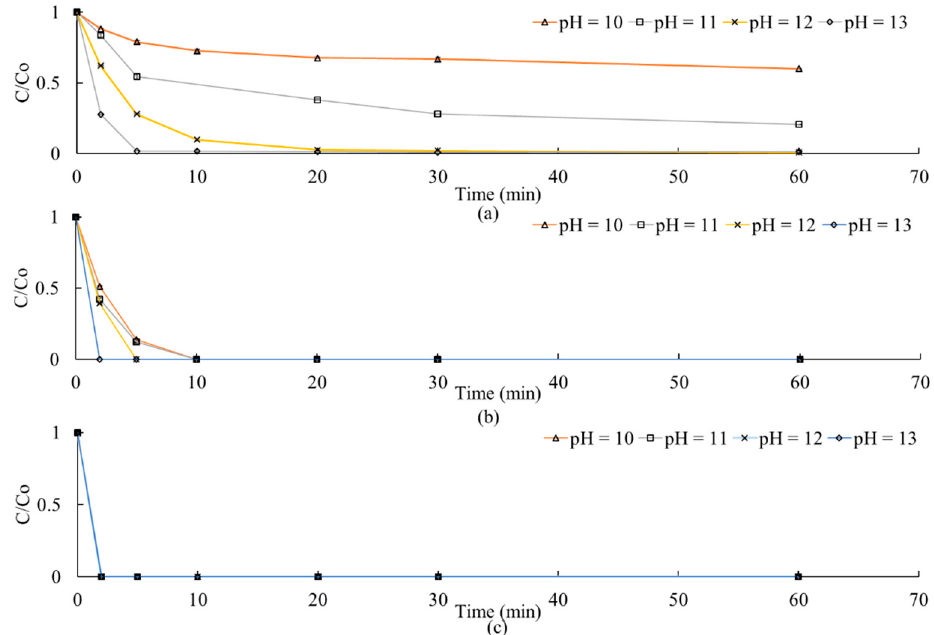
Figure 6. Sulfolane degradation in SWW with alkaline ozonation; ( a ) no dilution, ( b ) 5 × dilution, and ( c ) 500 × dilution. The error bars represent the variation of duplicates.